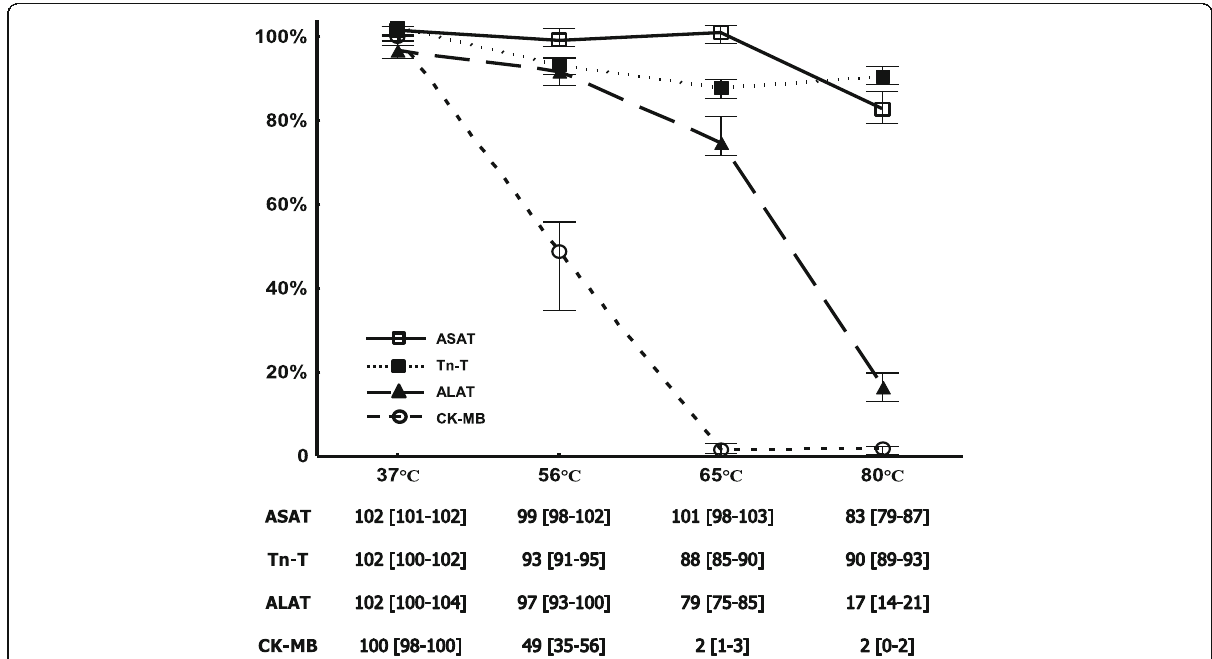
Fig. 1 The levels of Troponin T (Tn-T), creatine kinase isoenzyme MB (CK-MB), and aspartate aminotransferase (ASAT) preoperatively (Pre), at the end of surgery (T0), and 3 h (T3) and 20 h (T20) postoperatively displayed as median and 25th to 75th percentile. The figures for the mean values, the 25th to 75th percentiles, and the P values for comparison of the three groups are given in Table 3. The changes within the three groups over time are significant for all three markers for myocardial injury ( P <